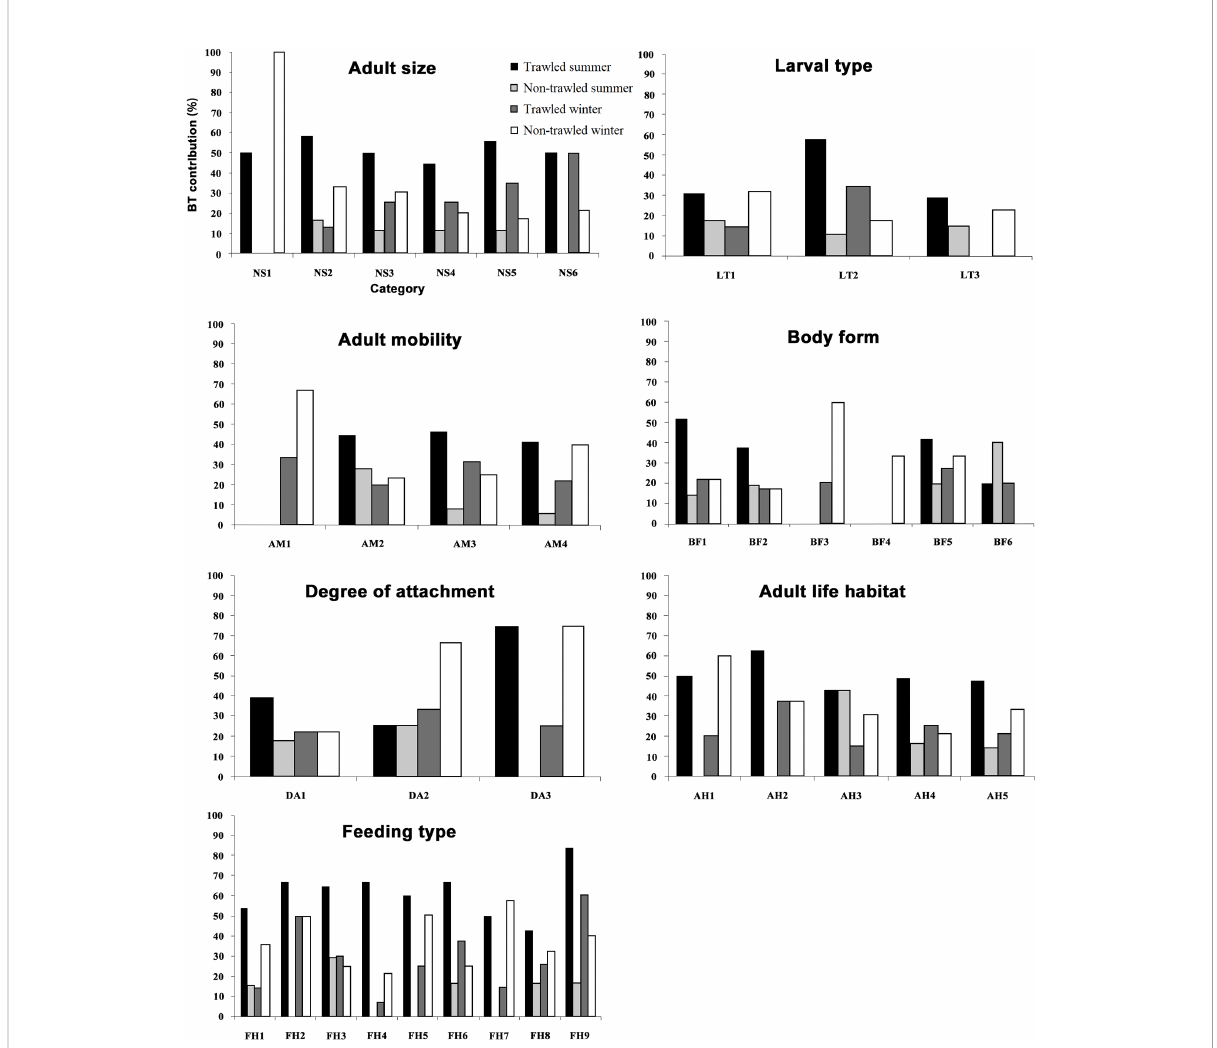
FIGURE 6 Biological trait (BT) contribution for rare species from summer and winter (trawled and non-trawled treatments) measured as percent of the whole trait pool. The biological trait is ranked as presence/absence. (Size, NS1:< 5 mm; NS2: 5 mm-1 cm; NS3: 1-3 cm; NS4: 3-6 cm; NS5: 6-10 cm; NS6: > 10 cm; Larval type, LT1: Planktotroph; LT2: Lecitotroph; LT3: Direct development; Mobility, AM1: None; AM2: Low; AM3: Medium; AM4: High; Body form, BF1: Short/cylindrical; BF2: Dorsally fl at; BF3: Laterally fl at; BF4: Ball shape; BF5: Long thin; BF6: Irregular; Attachment, DA1: None; DA2: Temporary; DA3: Permanent; Life Habitat, AH1: Sessile; AH2: Tube (permanent); AH3: Tube (semi-permanent); AH4: Burrower; AH5: Surface crawler; Feeding, FH1: Suspension/ fi lter; FH2: Scraper/grazer; FH3: Surface deposit feeder; FH4: Subsurface deposit feeder; FH5: Dissolved matter/symbiont; FH6: Large detritus/sand licker; FH7: Scavenger; FH8: Carnivore/omnivore;FH9: